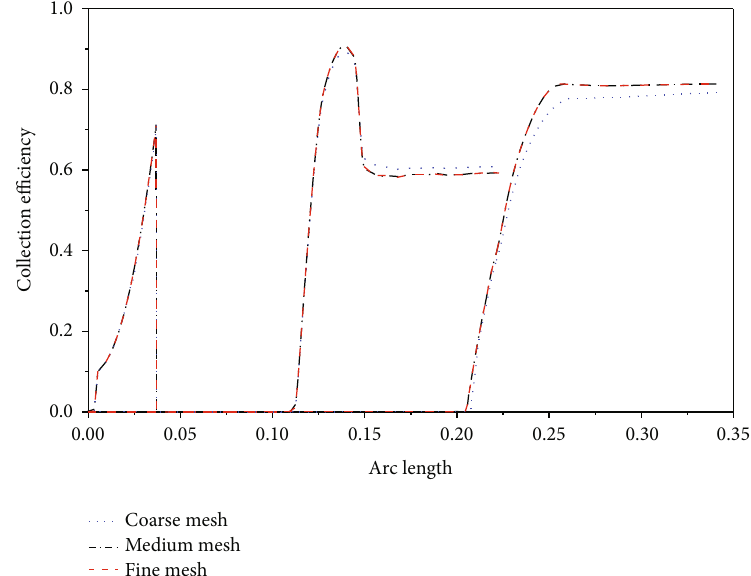
Figure 11: Collection e ffi ciency distribution for the pitot tube with three di ff erent mesh resolutions. Arc length is de fi ned as the ratio of curve distance from the original point and the total length of the tubes.